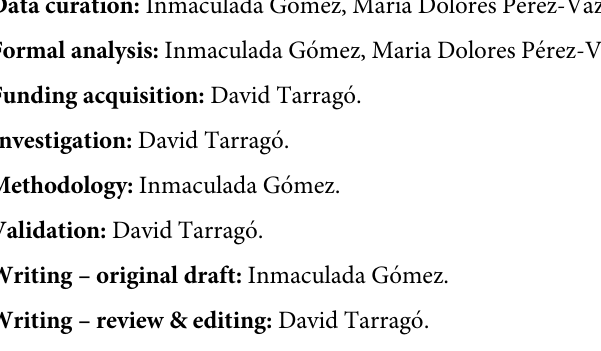
S1 Table. Detailed information for each patient regarding date of request, age, native country hospital of origin and subtype. S2 Table. Number and proportion of detected subtypes of HHV-8 in the different regions of Spain during the period